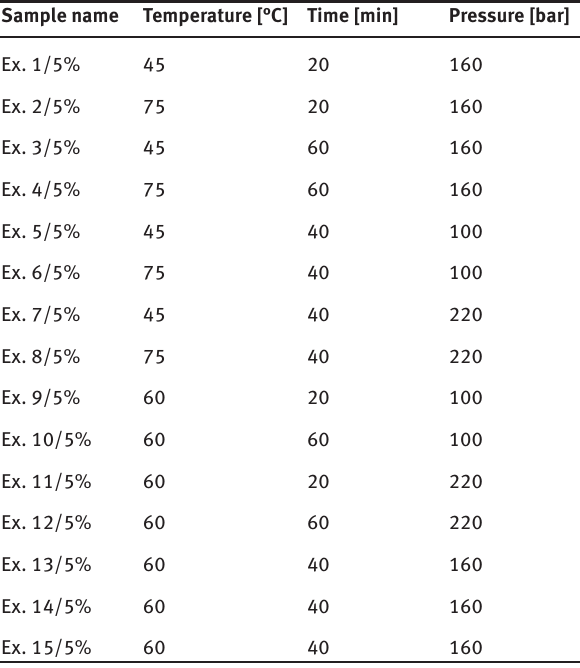
Table 1: Conditions of supercritical carbon dioxide extraction for 5% ethanol concentration.